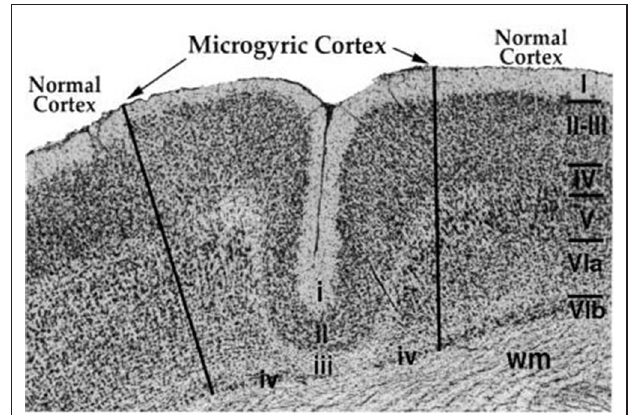
FIGURE 2 | Sample microgyric lesion in rat parietal cortex following a P1 focal freezing lesion. The six normal cortical layers are denoted with the Roman Numerals I–VIb, and wm denotes cortical white matter. The microgyric cortex is composed of cortical layers i–iv and shows a distinct fold in otherwise smooth cortex. From Peiffer, A.M., Rosen, G.D. and Fitch, R.H. (2002). Rapid auditory processing and MGN morphology in rats reared in varied acoustic environments. Dev. Brain Res. 138,